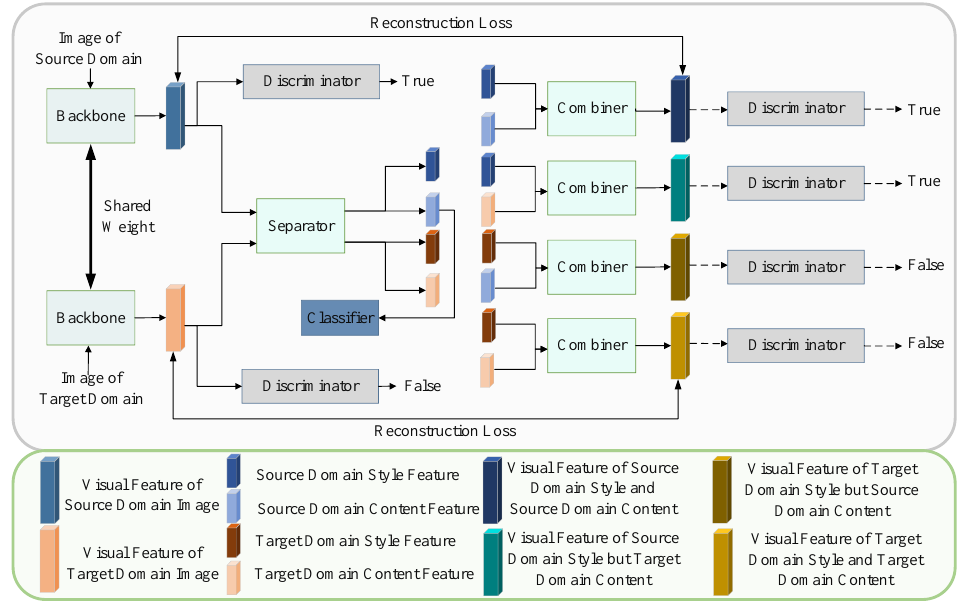
Figure 1. The overall framework of our proposed